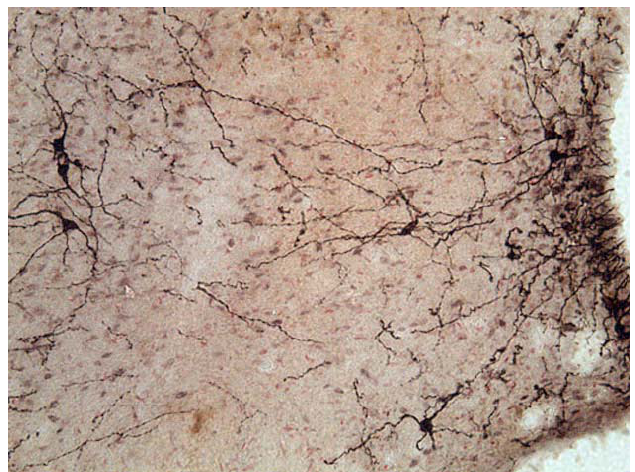
FIGURE 1. An example of CTR-positive neurons in the rat hindbrain that appear to form a network. Networks of calcitonin receptor (CTR)–positive neurons are often found[38] in key structures associated with energy homeostasis and feeding behavior including the NTS, paraventricular nucleus (PVN), lateral hypothalamic area (LHA), arcuate nucleus, as well as components of the limbic (nucleus accumbens), circadian (suprachiasmatic nucleus), and other systems (locus coeruleus). The relationship between CTR-positive neural networks and particular physiological functions has not yet been described.